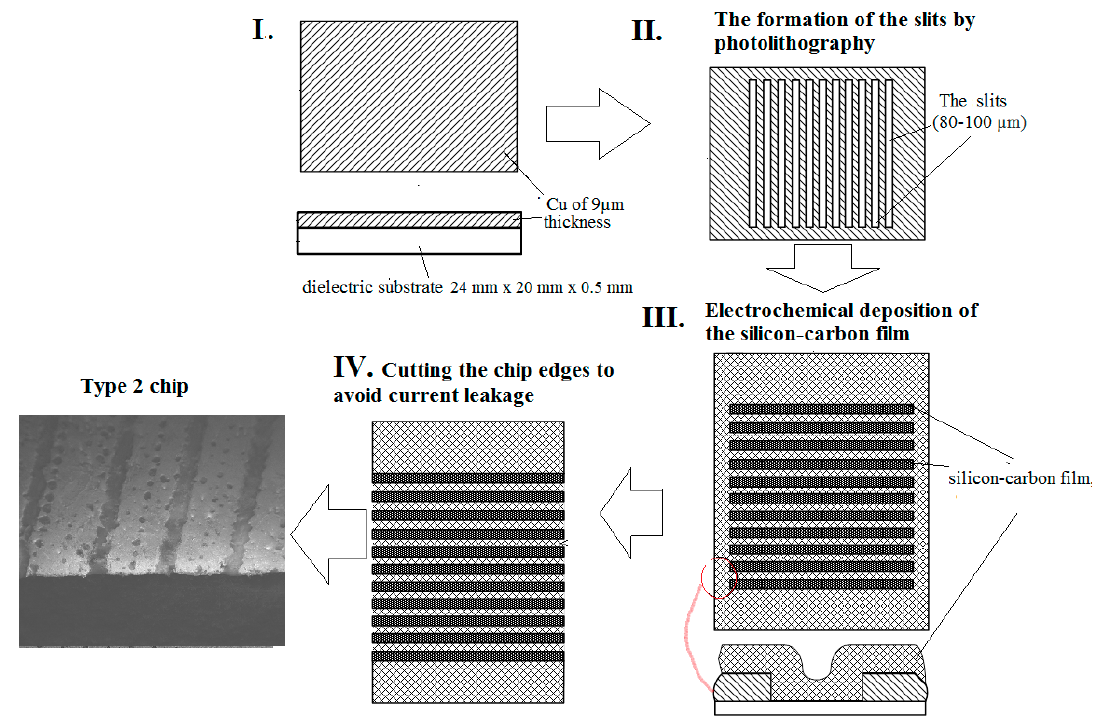
Figure 2. General sensor fabrication process on a dielectric substrate with copper electrodes (type-2).